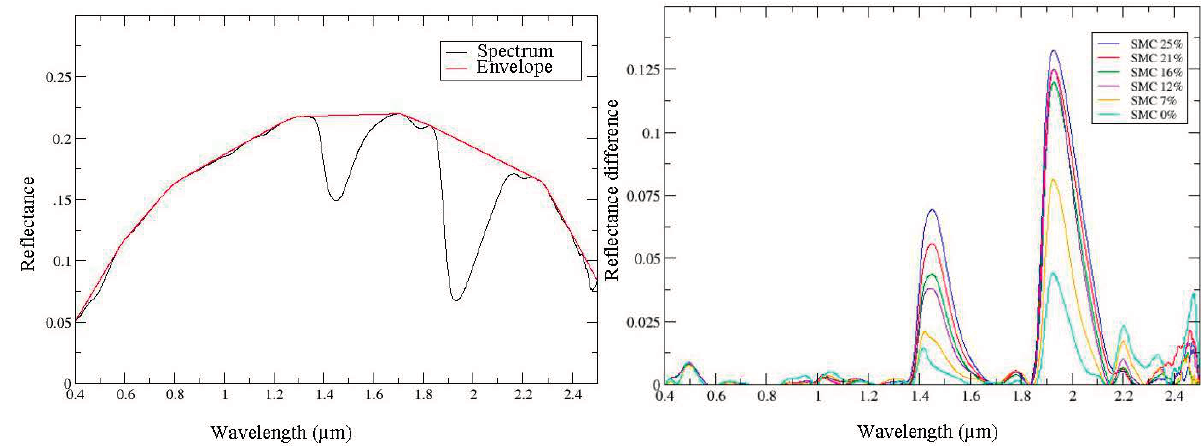
Figure 5. Illustration of the convex envelope method applied on a measured spectral signature ( Left ) and the difference between convex envelope and spectrum according to SMC ( Right